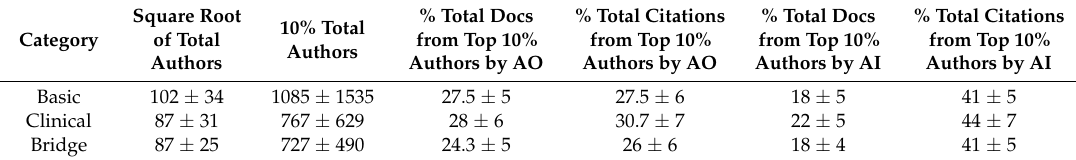
Table 5. Price’s Square root Law and Garfield’s Law at 10%.